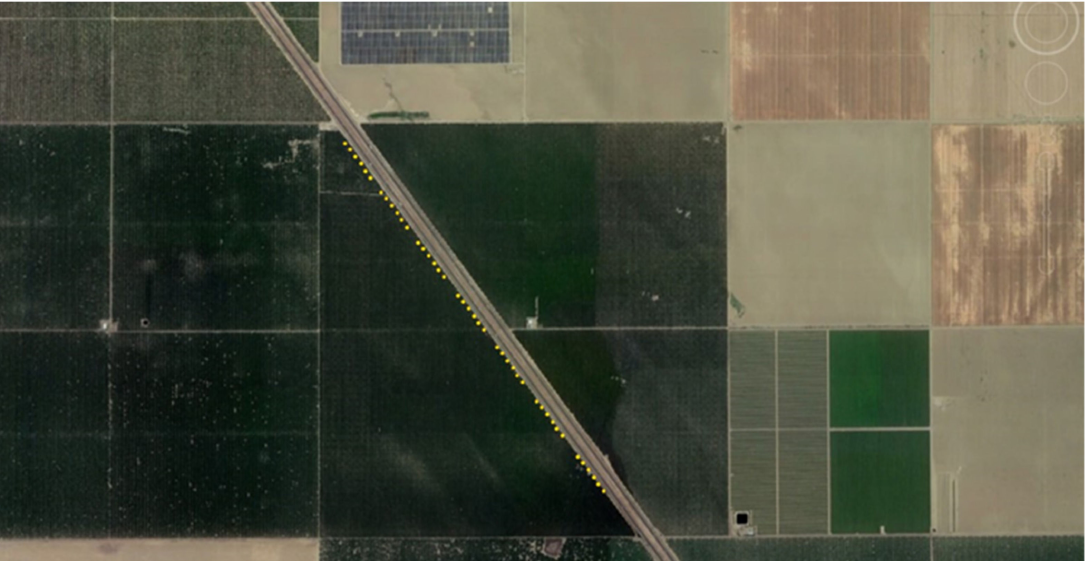
Figure 2. Plot arrangement for comparison of navel orangeworm captured in conventional sticky traps and detected with FlightSensor. Seven replicate blocks each contained 6 treatments: either conventional sticky wing traps or FlightSensor; each baited with either a pheromone monitoring lure, or an ovibait female attractant, or a phenyl propionate (PPO) pouch. Sensors and wing traps were placed at the end of orchard rows. The seven replicate blocks were along 1.8 km of the edge of a mature pistachio